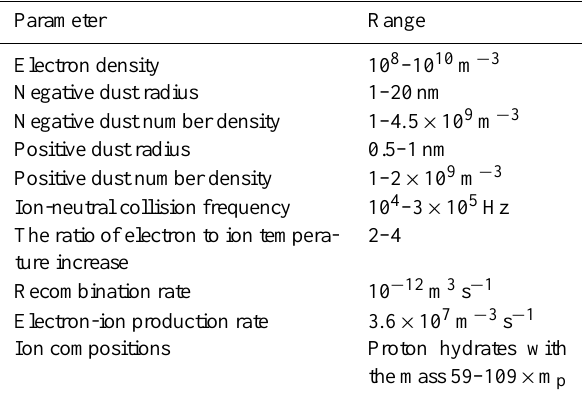
Table 1. Range of important parameters considered in the model.